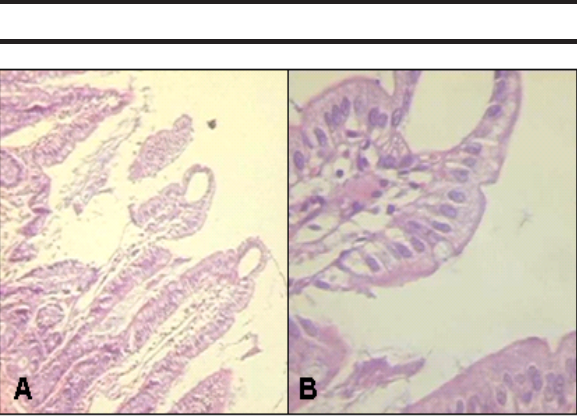
FIGURE 3 - Microphotograph of level 0 of Chiu’s Score 6 of intestinal mucosa (HE, A x100, B x400)